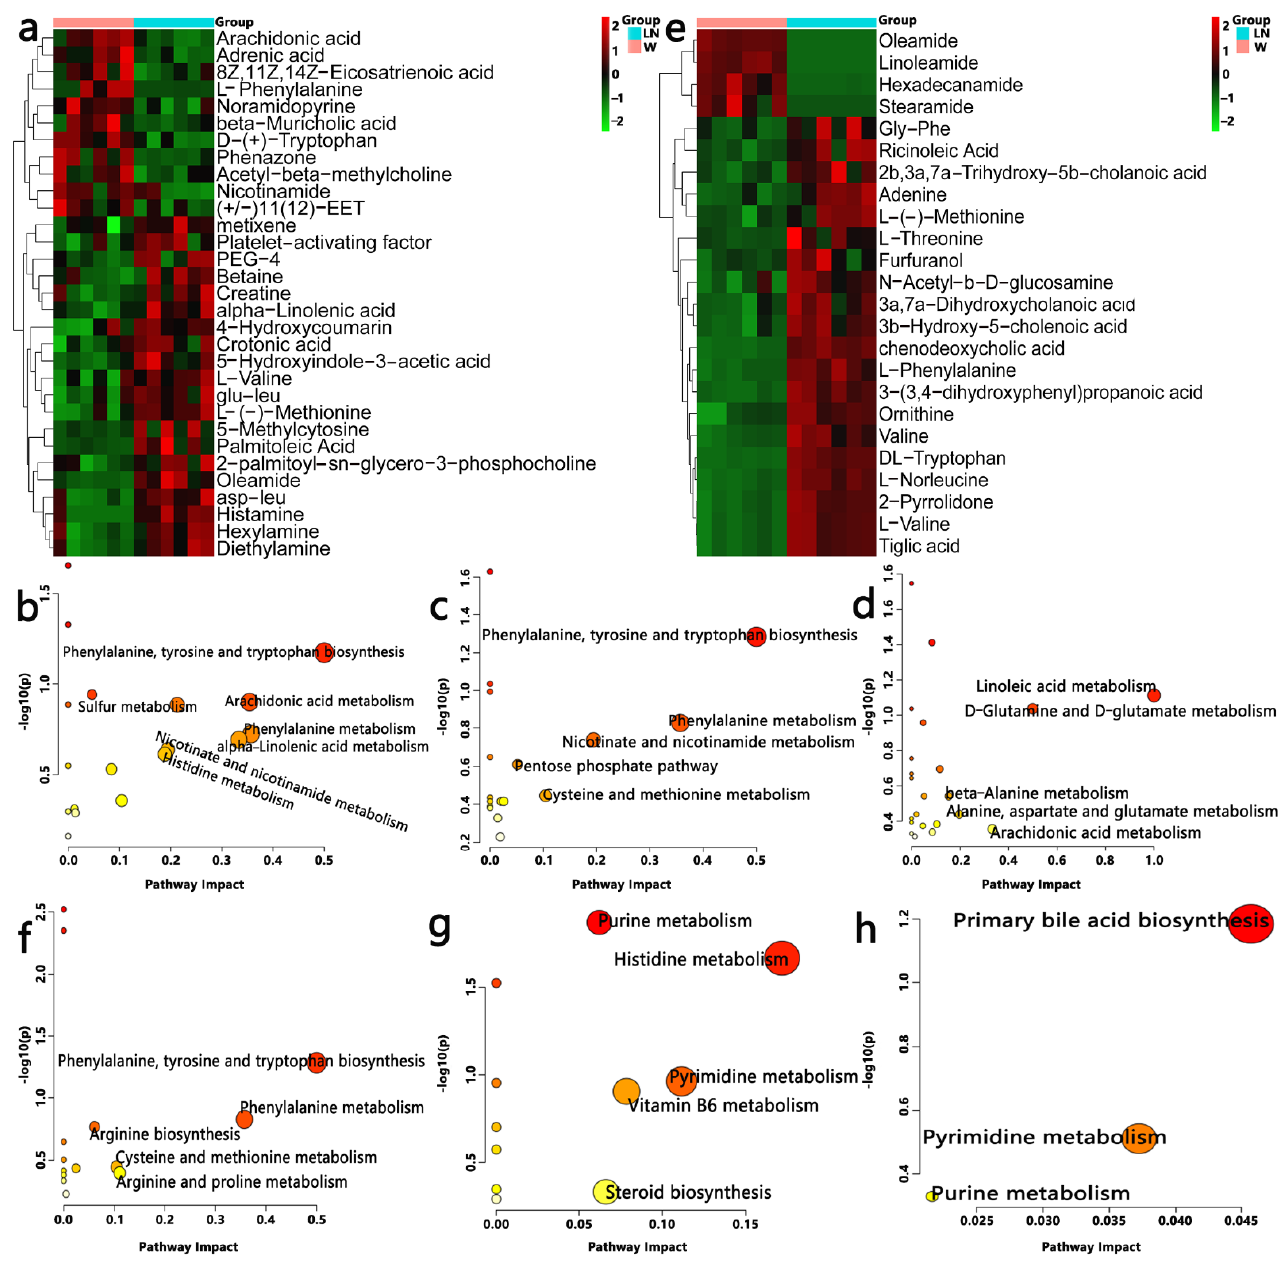
Figure 5. Effects of PFM ‐ SR37 ‐ 3 and PFM ‐ SR61 ‐ 2 on gut and blood metabolomes. ( a , e ) are heatmaps between W and LN groups constructed from the important metabolites of serum and cecal samples, respectively. A hierarchically clustered heat map showing the relative increase/decrease in metabolite contents between individual samples and their similarity. Columns correspond to different groups, and rows correspond to the altered metabolites. Color keys indicates the metabolite expression value; green is the lowest and red is the highest. ( b – d ) are metabolomic views of serum samples from the pathway analysis performed using MetaboAnalyst between the W and LN groups, between the LN and LN + SR37 ‐ 3 groups, and between the LN and LN + SR61 ‐ 2 groups, respectively. On the other hand, ( f – h ) are metabolomic views of cecal contents samples. cont W: animals not treated with L ‐ NAME receiving standard chow; cont LN: L ‐ NAME ‐ treated rats receiving standard chow; LN + SR37 ‐ 3: L ‐ NAME ‐ treated rats receiving PFM ‐ SR37 ‐ 3; LN + SR61 ‐ 2: L ‐ NAME ‐ treated rats